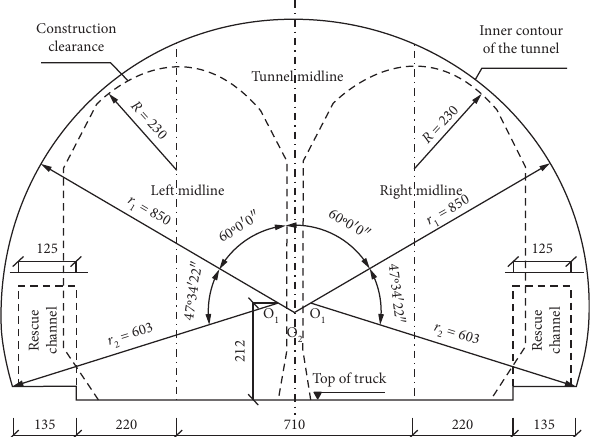
Figure 2: Tunnel clearance